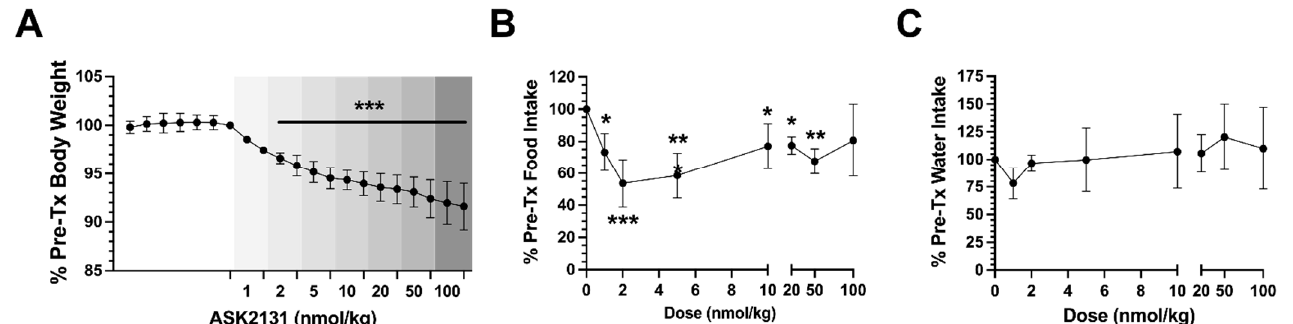
Figure 4. Changes of weight ( A ), food intake ( B ), and water intake ( C ) in DIO rats treated with ASK2131 after 6 days of baseline measures, starting dose 1 nmol/kg day, then increase to 2, 5, 10, 20, 50, and finally 100 nmol/kg every 2 days. The low dose of ASK2131 was effective in significantly reducing body weight and food intake, higher doses did not result in greater reductions of food intake and body weight. Analysis by Two-Way ANOVA test with Šídák’s multiple comparisons test. * p < 0.05 vs. baseline, ** p < 0.01 vs. baseline, *** p < 0.0001 vs. baseline.